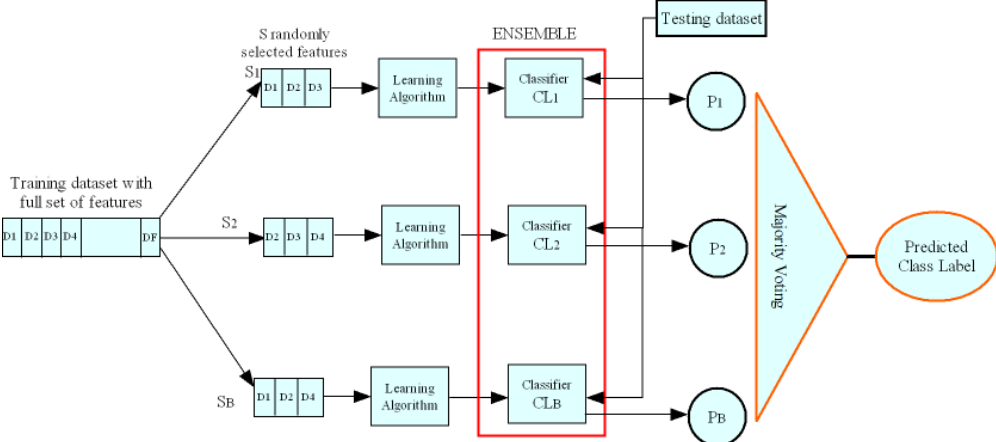
Figure 4. Random Subspace Learning process: training and